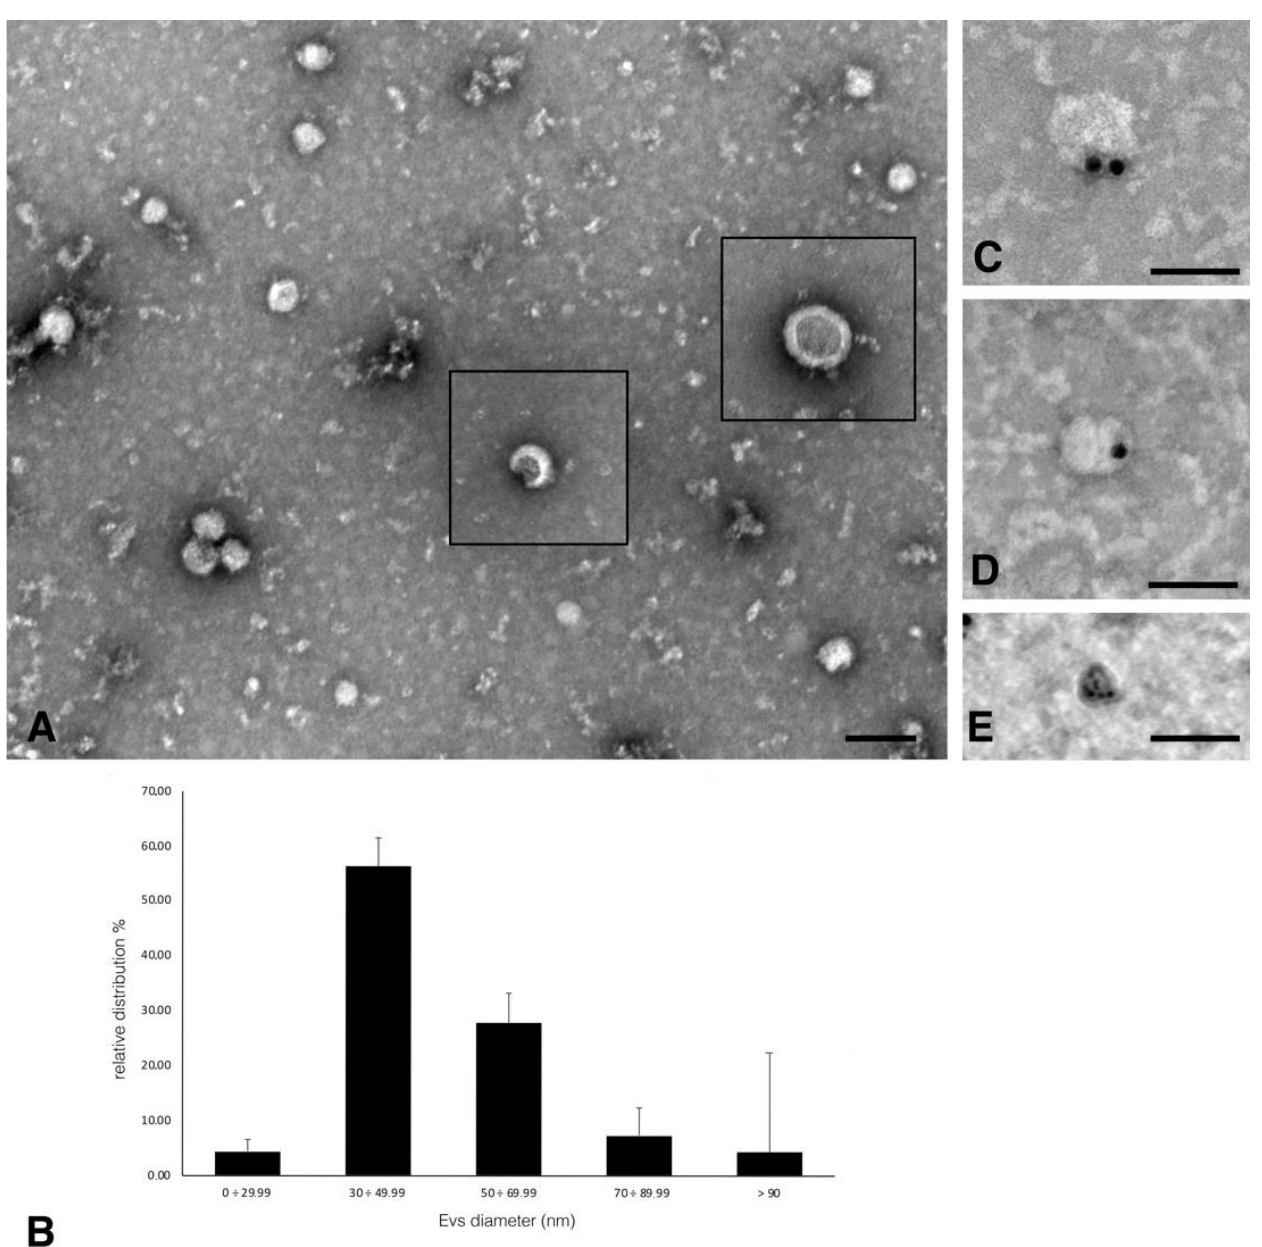
Figure 7. Negative staining of EVs from dH9c2 supernatant and Cx26 immunolocalization. ( A ) Representative images of EVs having a roundish and cup-shaped (squares) morphology. Scale bar 100 nm. ( B ) Diagram showing the EVs relative distribution in different dimension classes. The total number of counted EVs was 429. ( C – E ) Representative images of Cx26 immunogold localization performed with 20 nm ( C , D ) and 10 nm ( E ) gold particles conjugated anti rabbit secondary antibodies. Scale bars 100 nm.